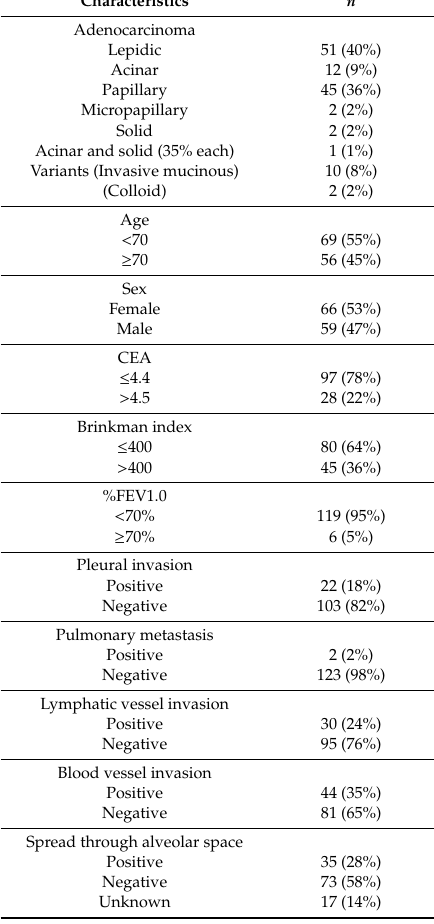
Table 5. Clinicopathological characteristics of patients in 125